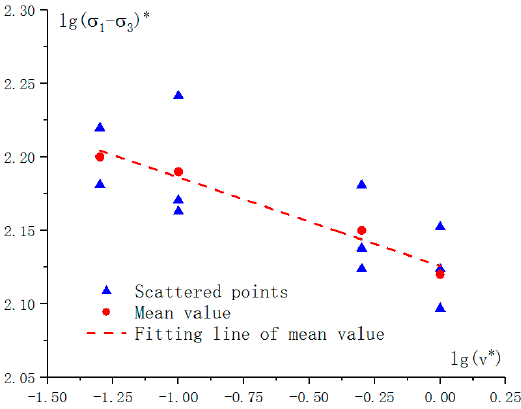
Figure 12. A logarithmic fit curve of residual strength and unloading rate.